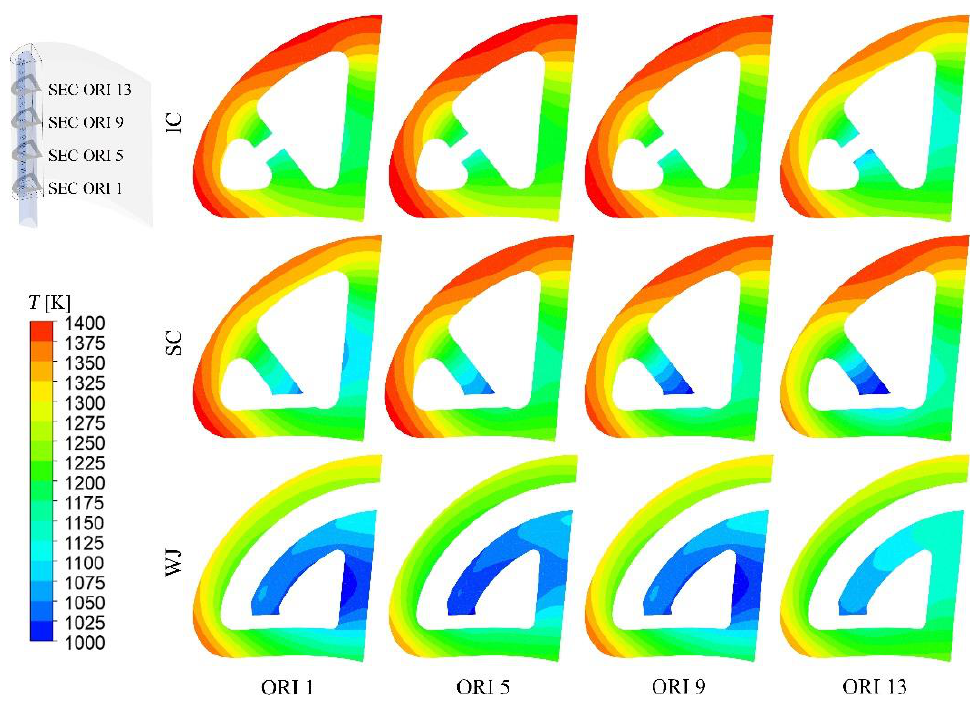
Figure 19. Temperature distributions in sections with different heights of the studied internal cooling structures ( Re j = 20,000).